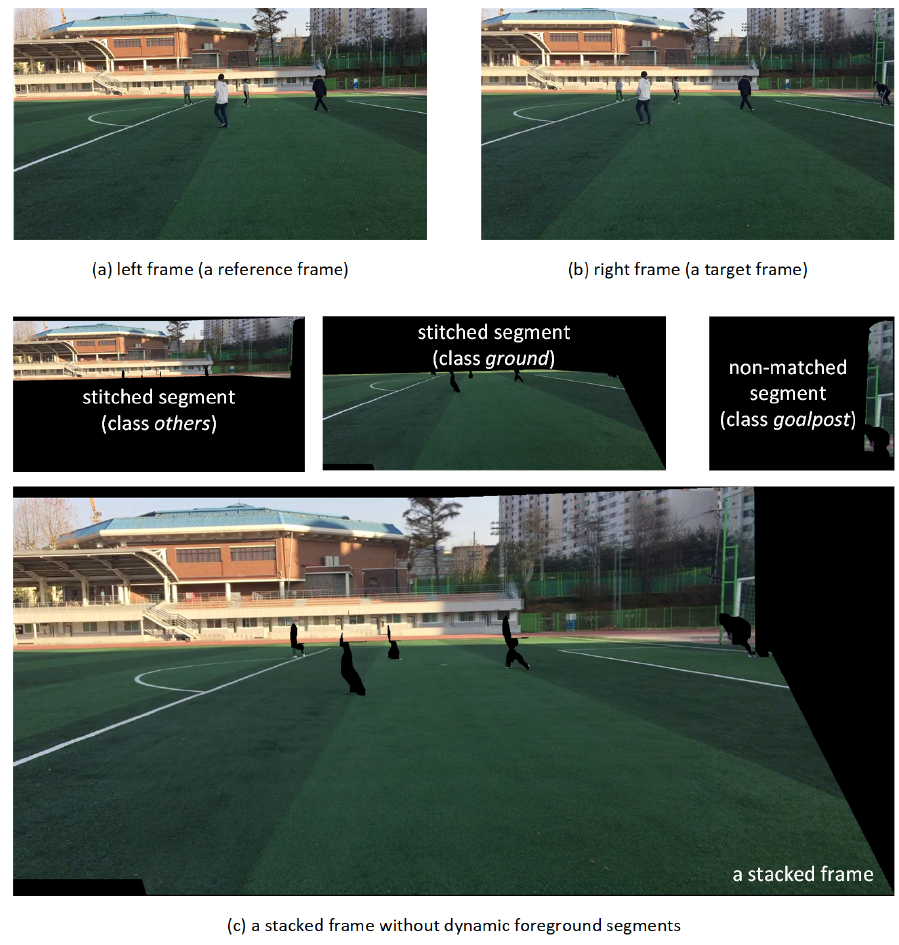
Figure 7. Segment-based stitching for background segments: seq1